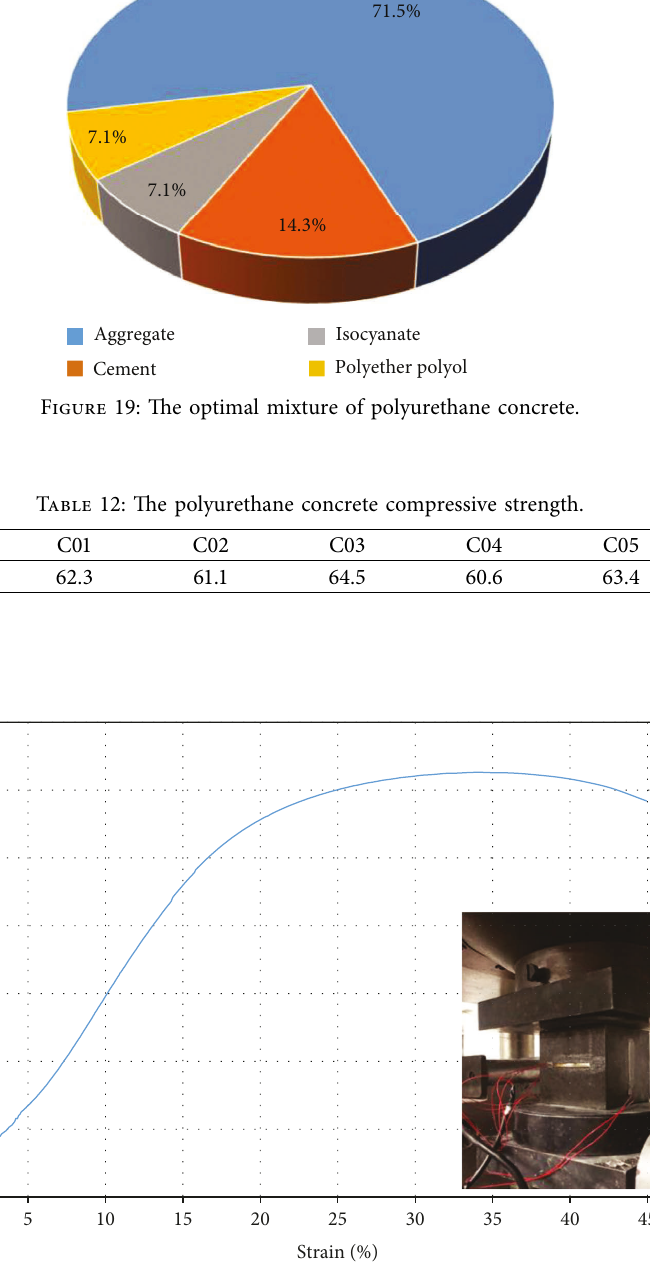
Figure 20: The compressive strength stress-strain curve of polyurethane concrete. Table 13: The polyurethane concrete tensile strength.